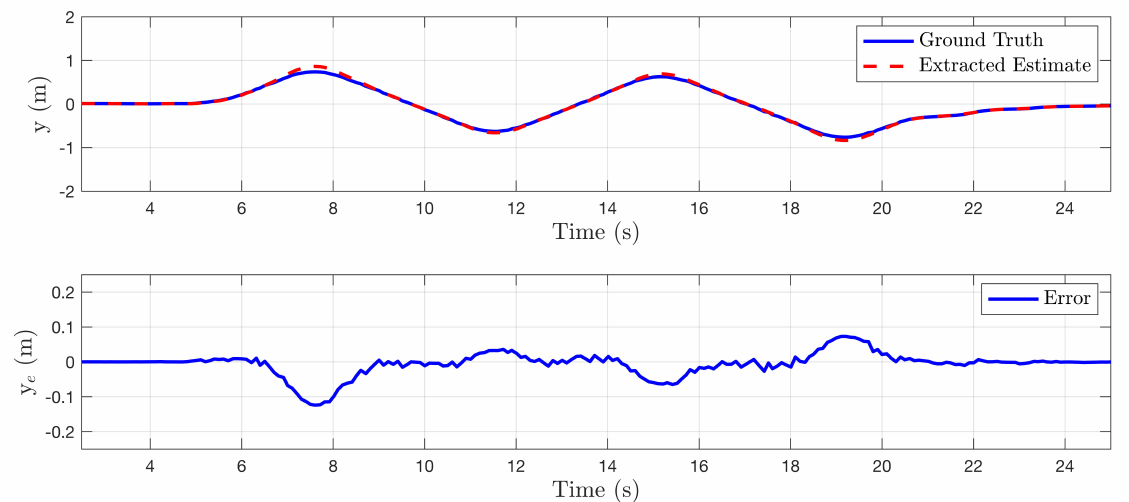
Figure 6. ( top ) Comparison of estimated lateral distance of cylinder centerline to ground truth as system moves back and forth laterally in environment. ( bottom ) State error plotted as a function of